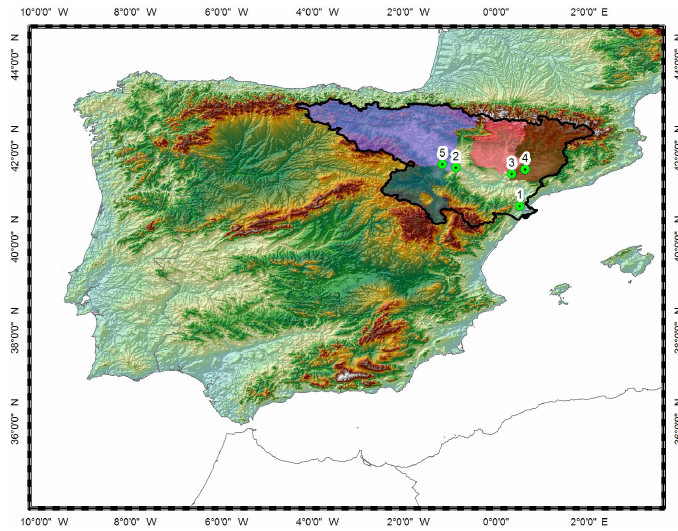
Figure 1. Map of the Iberian Peninsula case study